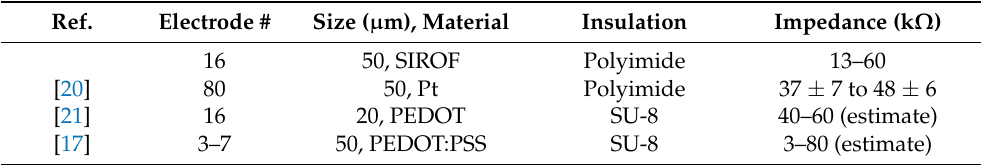
Table 1. Direct material and electrochemical comparison between helical arrays (top row) and select published 3D MEAs.